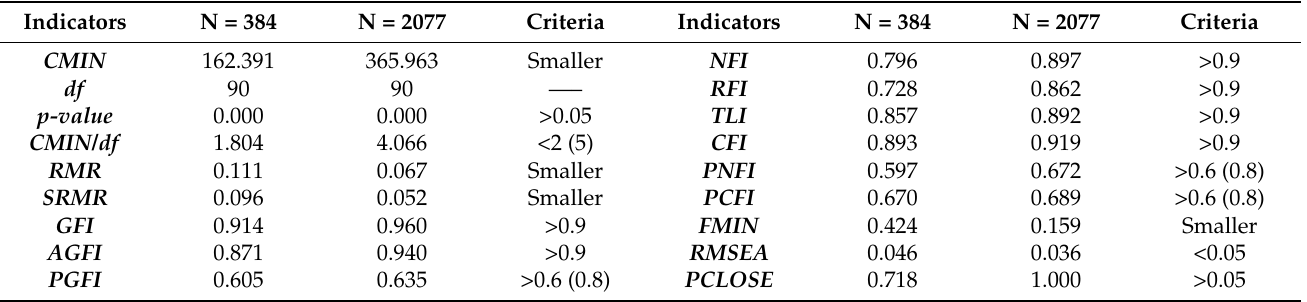
Table 6. Indicators of the goodness of fit of the final model with test sample and complete sample.